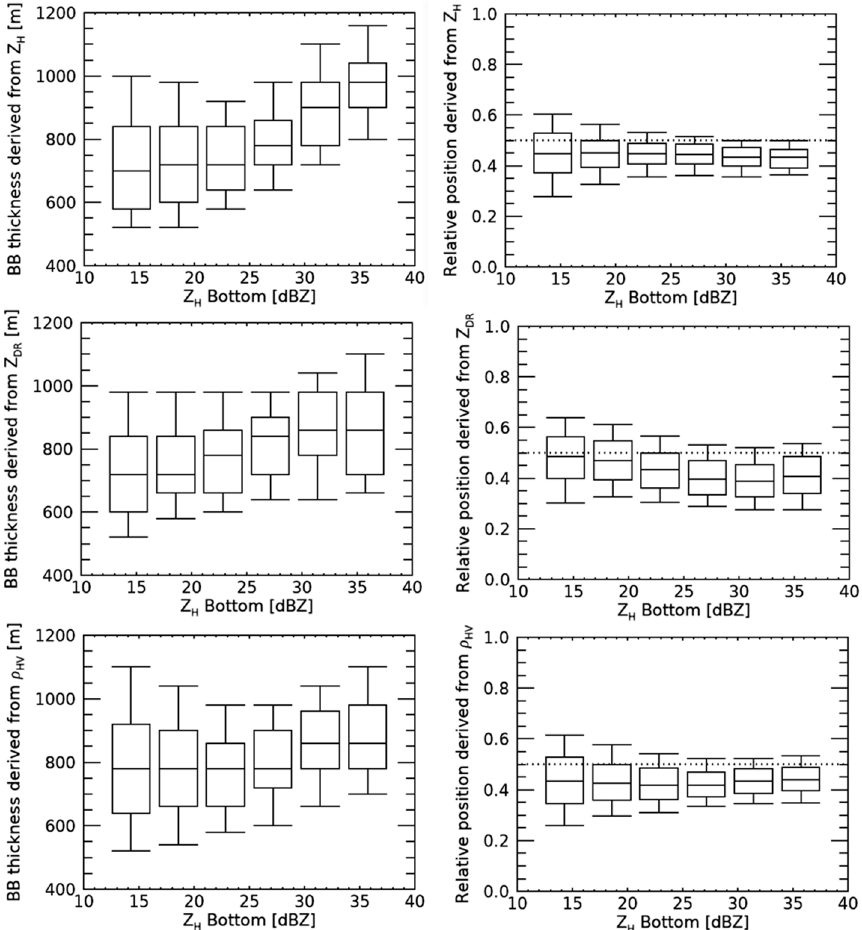
Figure 8. Box plots of the thickness of the BB ( left ) and relative position of BB PEAK ( right ) as a function of Z H BB BOTTOM . The dashed line indicates the symmetric structure of the BB.